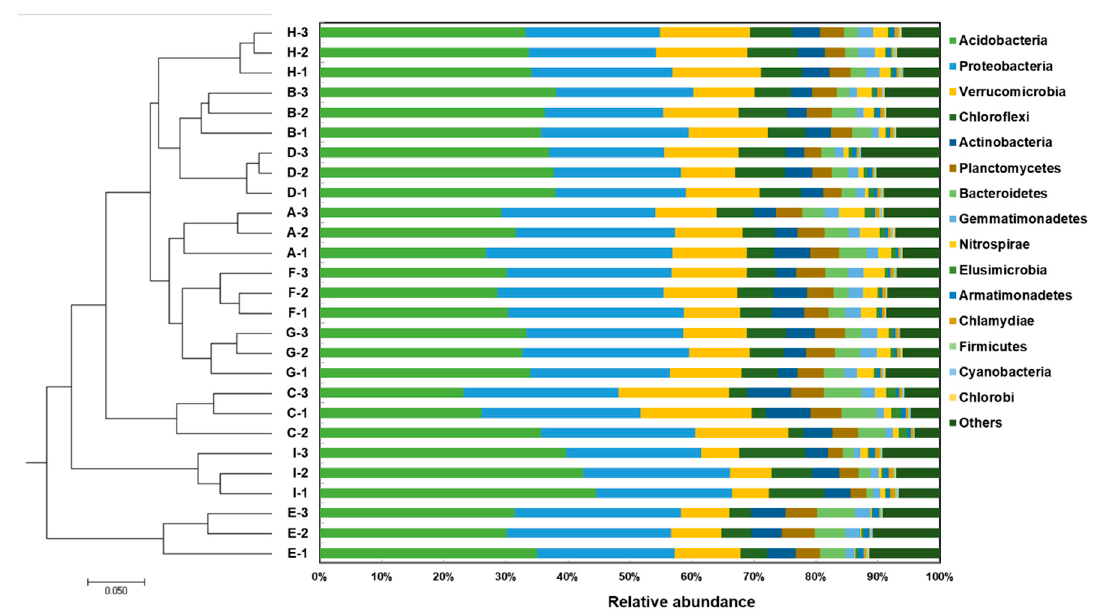
Figure 2. The relative abundance of taxonomic composition at the phylum level for bacteria across soil samples, with clustering tree on the left showing the similarities among the soil samples.